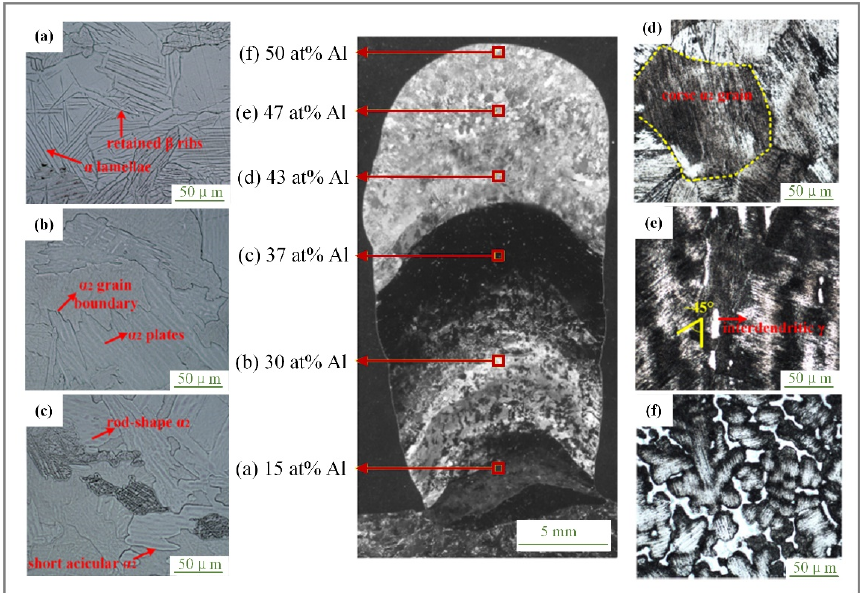
Figure 16. Microstructure with progressively higher Al content from the bottom to the top [72].